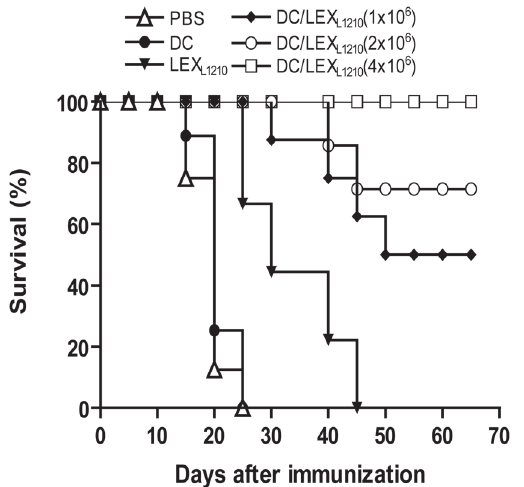
Figure 4. LEX L1210 and LEX L1210 -pulsed DCs induce anti- leukemia protective immunity against L1210 leukemia cells. Survival of mice prophylactically immunized with different vaccines. DBA/2 mice (n=8 per group) were immunized with phosphate- buffered saline (PBS), L1210-derived exosomes (LEX L1210 ), non-pulsed dendritic cells (DCs), and different doses of LEX L1210 -pulsed DCs (DC/ LEX L1210 ). On days 7–10 after immunization, all mice were challenged with L1210 leukemia cells. Vaccination with non-pulsed DCs (median survival time [MST], 20 d) did not significantly prolong the survival of mice as compared to the non-vaccinated PBS group (MST, 15 d), whereas LEX L1210 vaccination (MST, 30 d) improved survival as compared to the control group of non-vaccinated mice ( P , 0.05). In contrast, mice receiving different doses of DC/LEX L1210 (particularly 2 6 10 6 and 4 6 10 6 ) had significantly improved survival as compared to non-vaccinated mice ( P , 0.0001). Results were combined from 2 separate